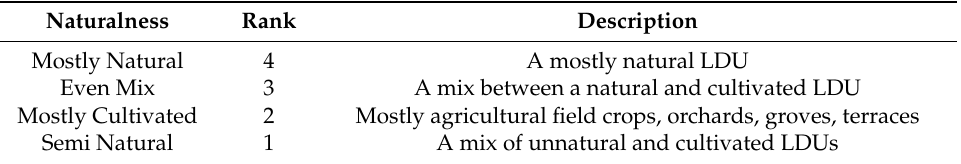
Table 6. Ranking system of LDUs according to